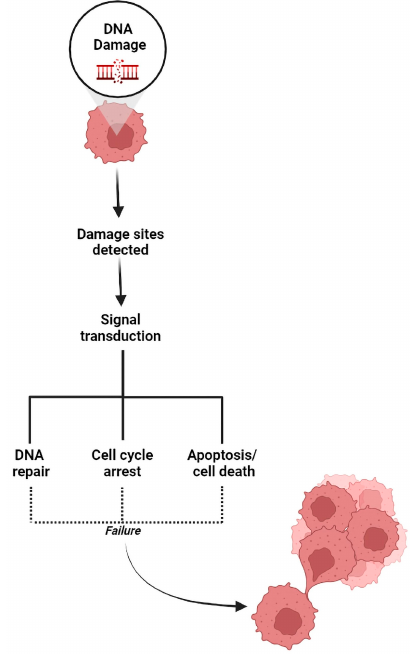
Figure 2. The DNA damage response is responsible for determining the cell’s future. DNA damage sensors recognize damage sites, transmit signals to related DNA damage repair systems, and determine whether the cell undergoes DNA damage repair, cell cycle arrest, or cell death. Any fault in this process could lead to genomic instability and cancer development.